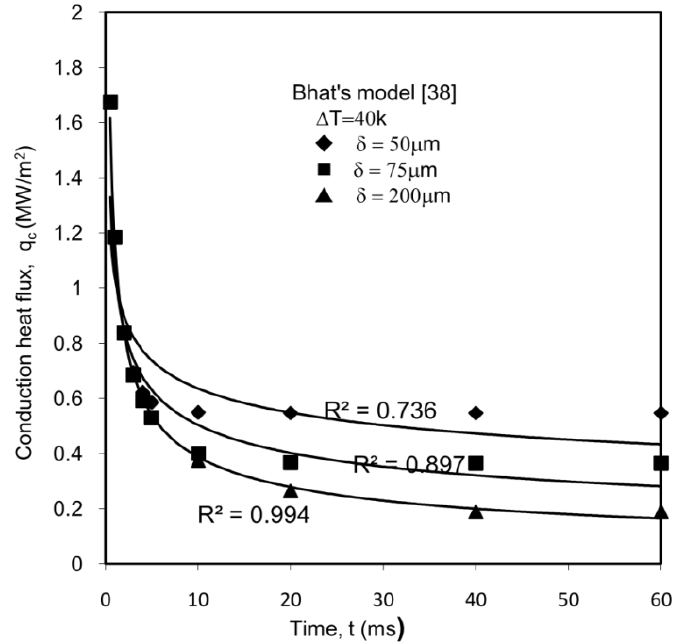
Figure 5. Transient conduction heat flux for different macrolayer thicknesses.